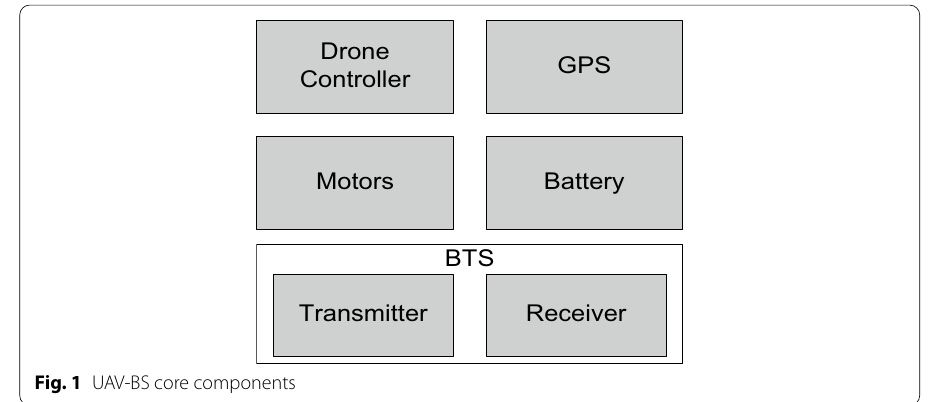
Fig. 1 UAV-BS core components